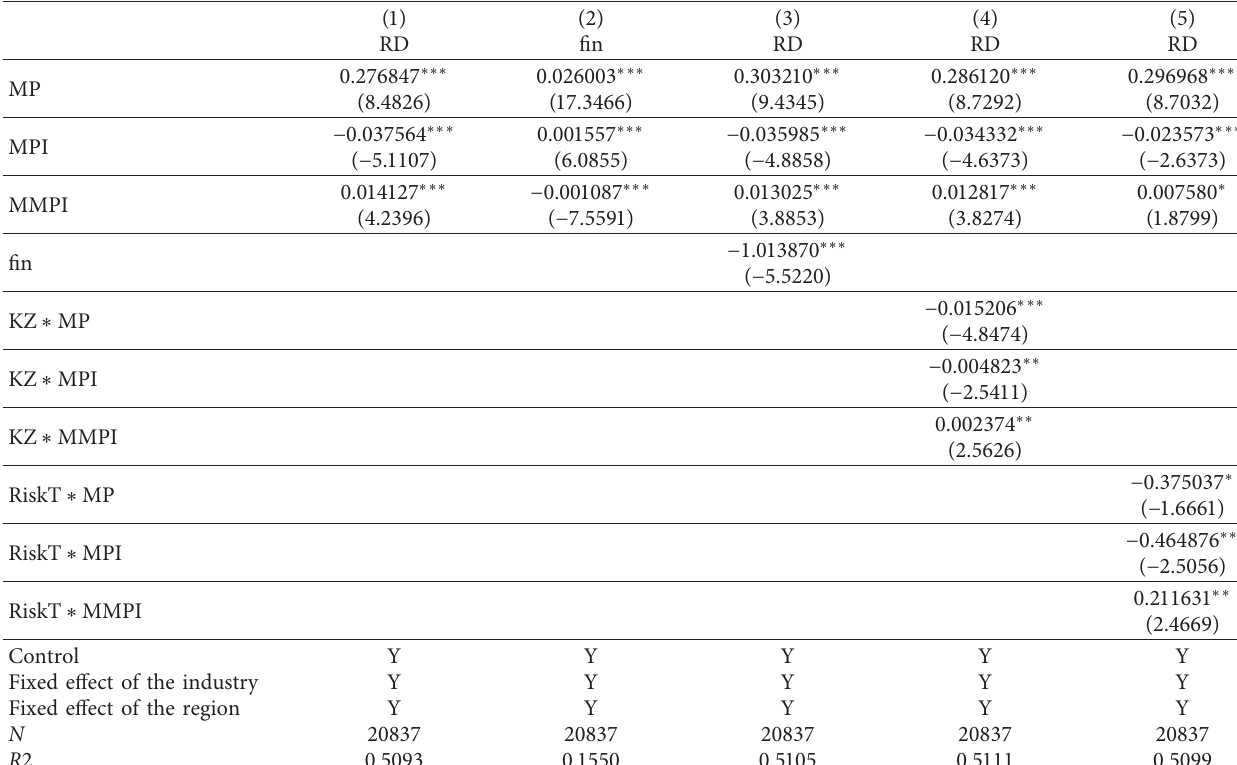
Table 5: Mechanism